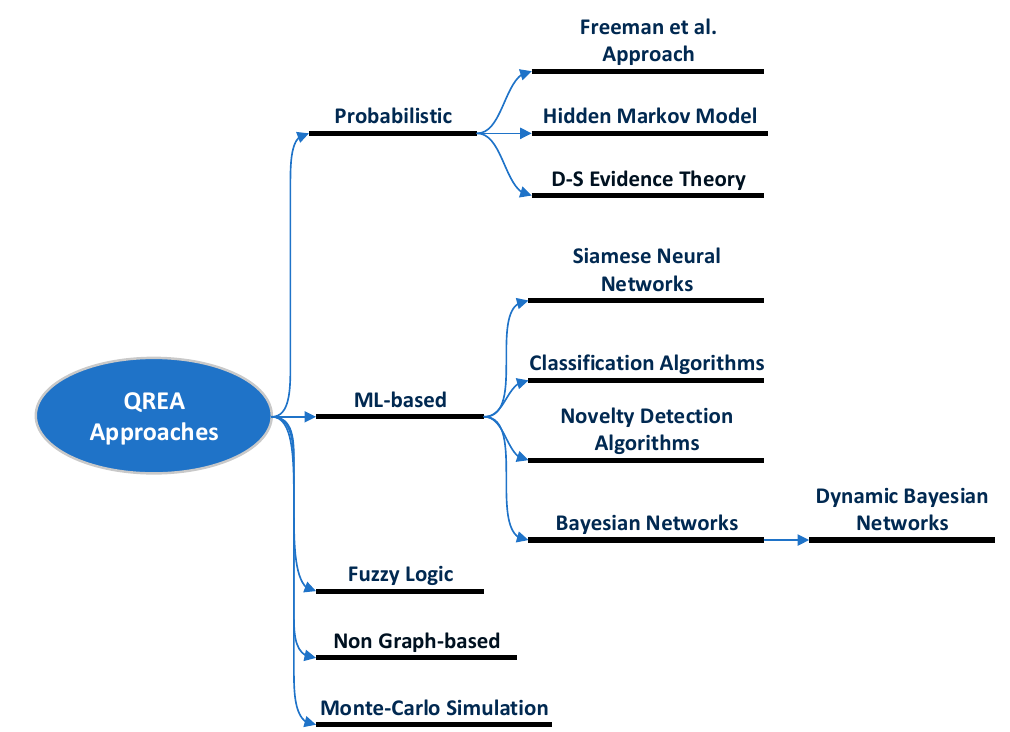
Figure 2. A taxonomy of Quantitative Risk Estimation Approaches. Freeman et al. [33].